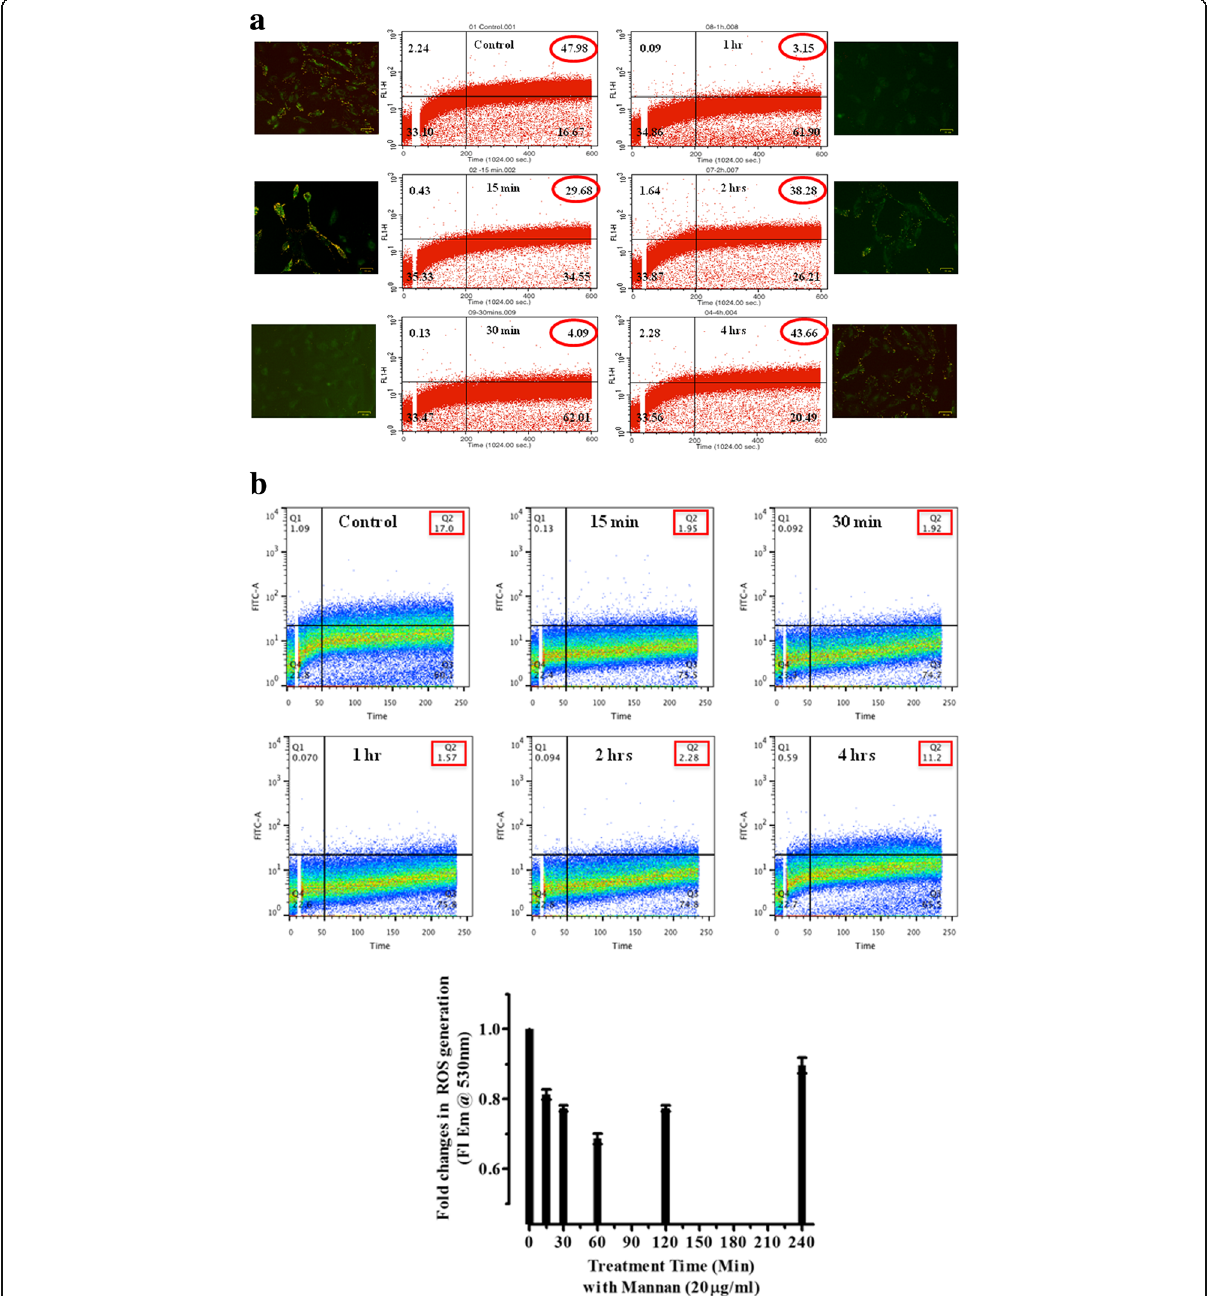
Fig. 2 a . Time kinetics of DiOC 6 (3) uptake in NKE cells following treatment with Mannan. Mitochondrial Membrane potential mediated sequestration of DiOC 6 (3) in mitochondria of NKE cells was assessed flowcytometrically as described in materials and method section. Briefly, cells were treated with mannan, and dye uptake with time was measured continuously using Ex λ 488 and Em λ 530. The results are representative of three independent experiments. Data was analyzed using FlowJo V10.1 software. Images to assess for changes in membrane potential using JC-1 dye (using green and red channels of ZOE ™ Fluorescence microscope) were also acquired after 10 min (incubation with dye) as described in materials and method section. The acquired images were merged and analysed using inbuilt software provided with the microscope. b . Time kinetics of ROS generation in NKE cells after treatment with Mannan. ROS mediated oxidation of CM-H 2 DCFDA and measurement of the fluorescent CM-DCF with time as an indicator of redox status of cells. Briefly, cells treated with mannan was harvested and thereafter oxidation of dye was measured flowcytometrically using Ex λ 488 and Em λ 530 as described under materials and methods. Obtained results presented are representative of three independent experiments. Data was analyzed using FlowJo V10.1 software. To confirm the changes in ROS levels following treatment of cells with mannan, the oxidation of CM-H 2 DCFDA dye was also measured using microplate reader, at Ex λ 488 nm and Em λ 530 nm. Results are representative of mean fluorescence and expressed as fold changes in mean